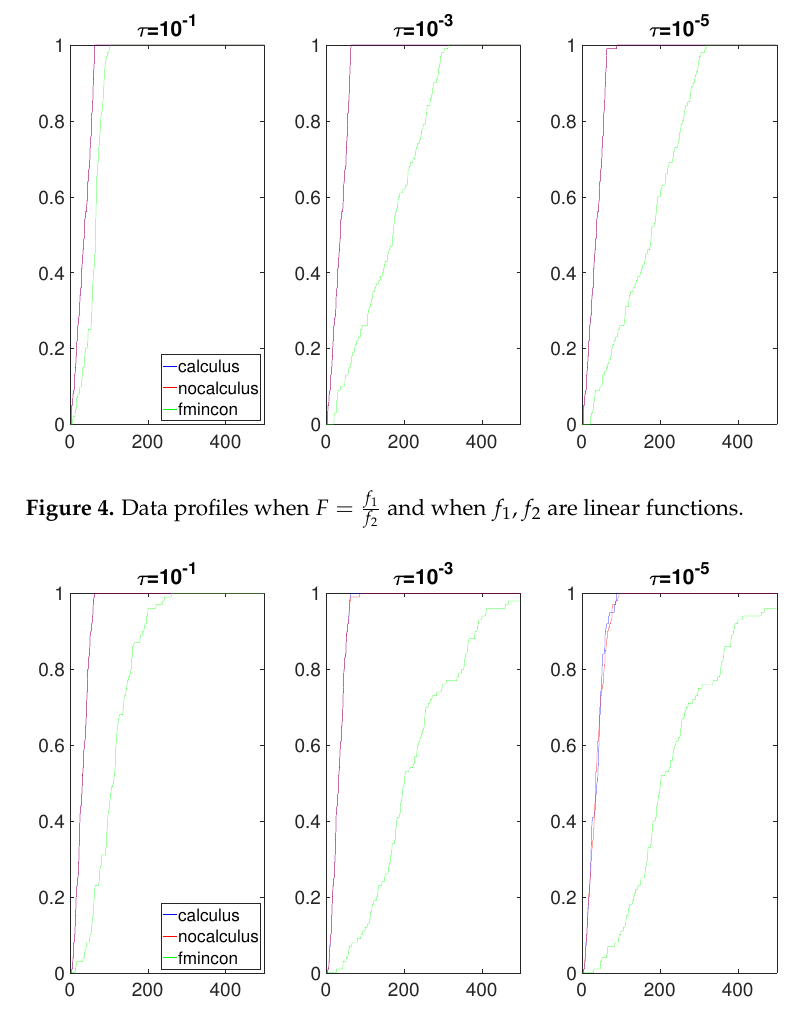
Figure 5. Data profiles when F = f 1